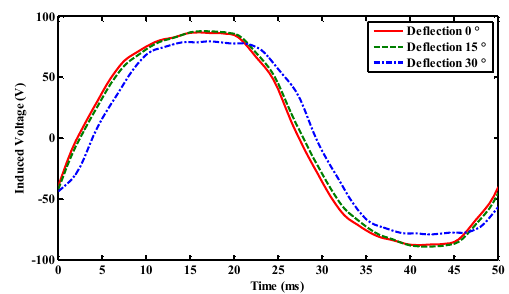
Figure 26. Induced voltage comparison diagram of phase A winding in three states.